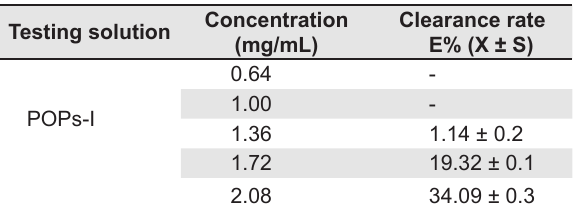
Table 1. Lipid peroxidation inhibition ability of the POPs-I (n = 5)